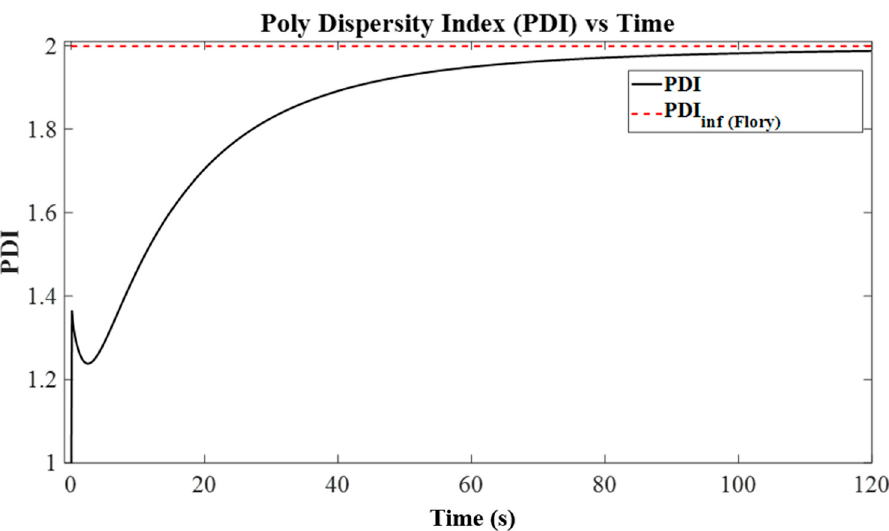
Figure 3. Polydispersity index according to Equations (36) and (37) ( K P = 100/s, K I = 1/s, K T = 0.1/s, K D = 0.01/s).